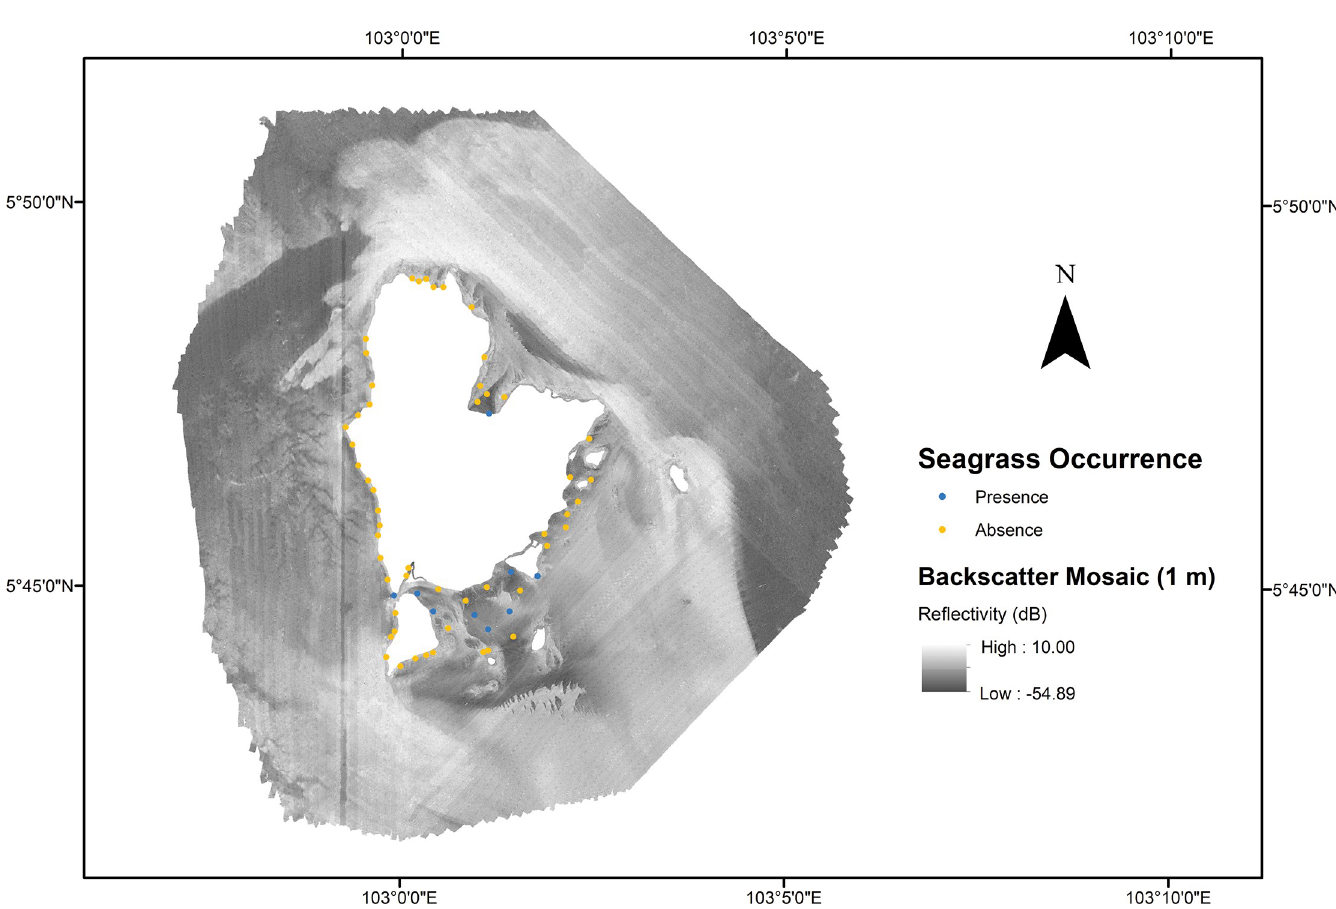
Fig 3. Backscatter mosaic of Redang archipelago. Backscatter mosaic of the study areas. Red and blue dots represent the presence and absence of seagrass occurrence, respectively.